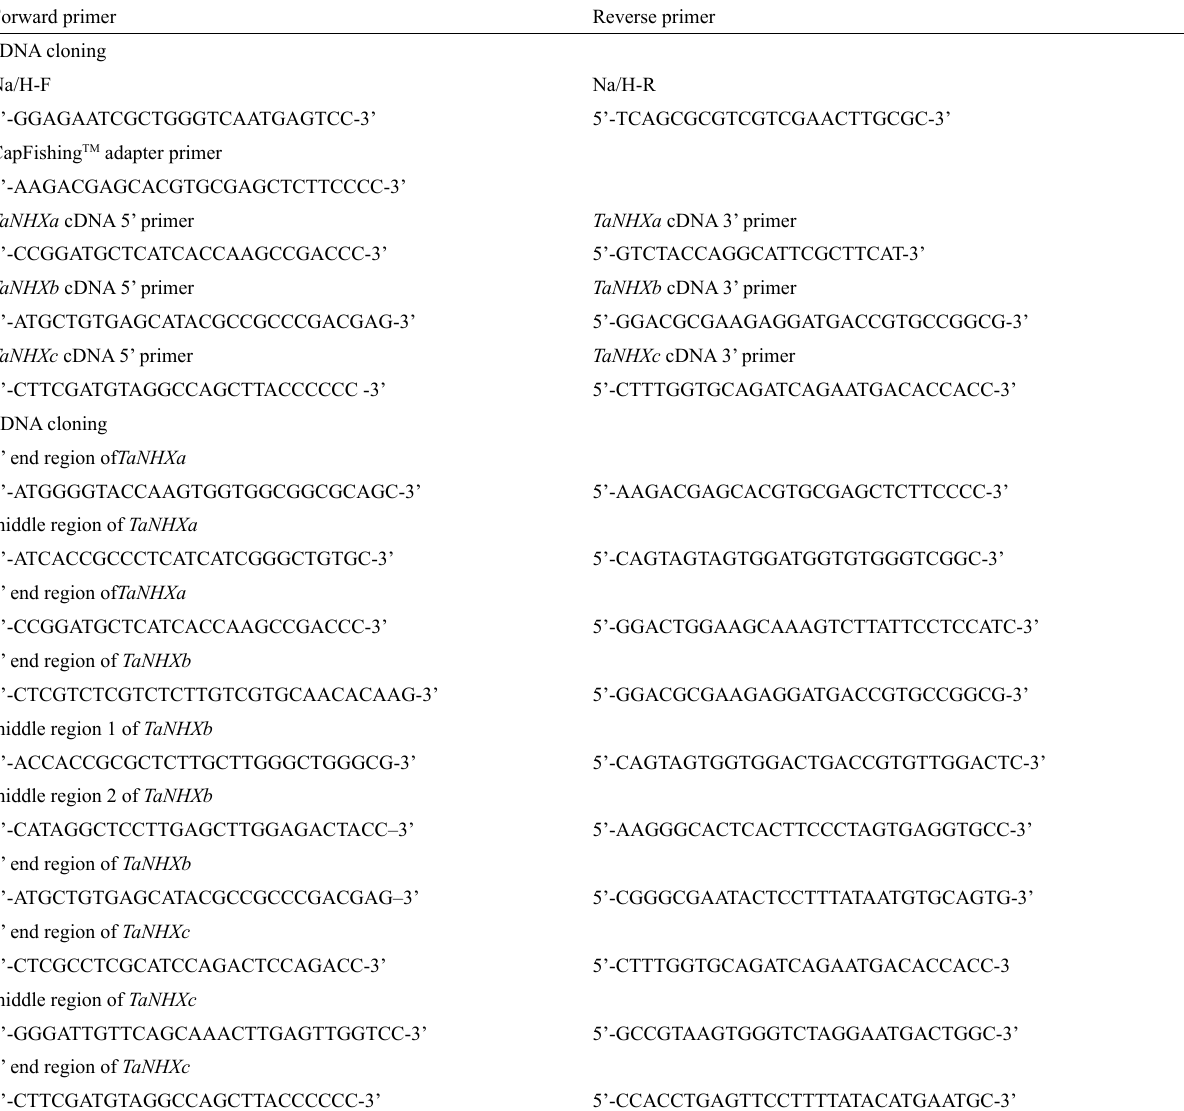
Table 1 – Primer sets designed for cloning cDNA and genome DNA of wheat TaNHX